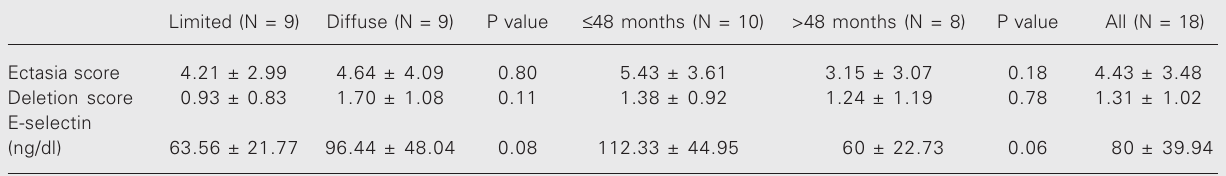
Table 1. E-selectin and capillaroscopic parameters (ectasia and deletion score) between disease subset and disease duration.